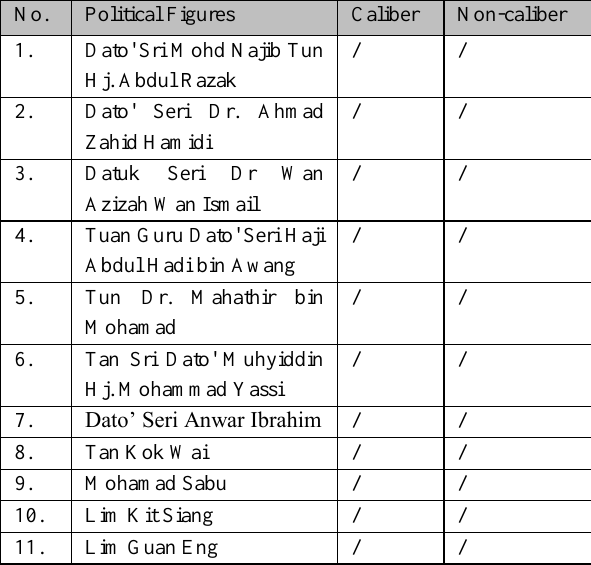
Table 3. Types of assessment to state political